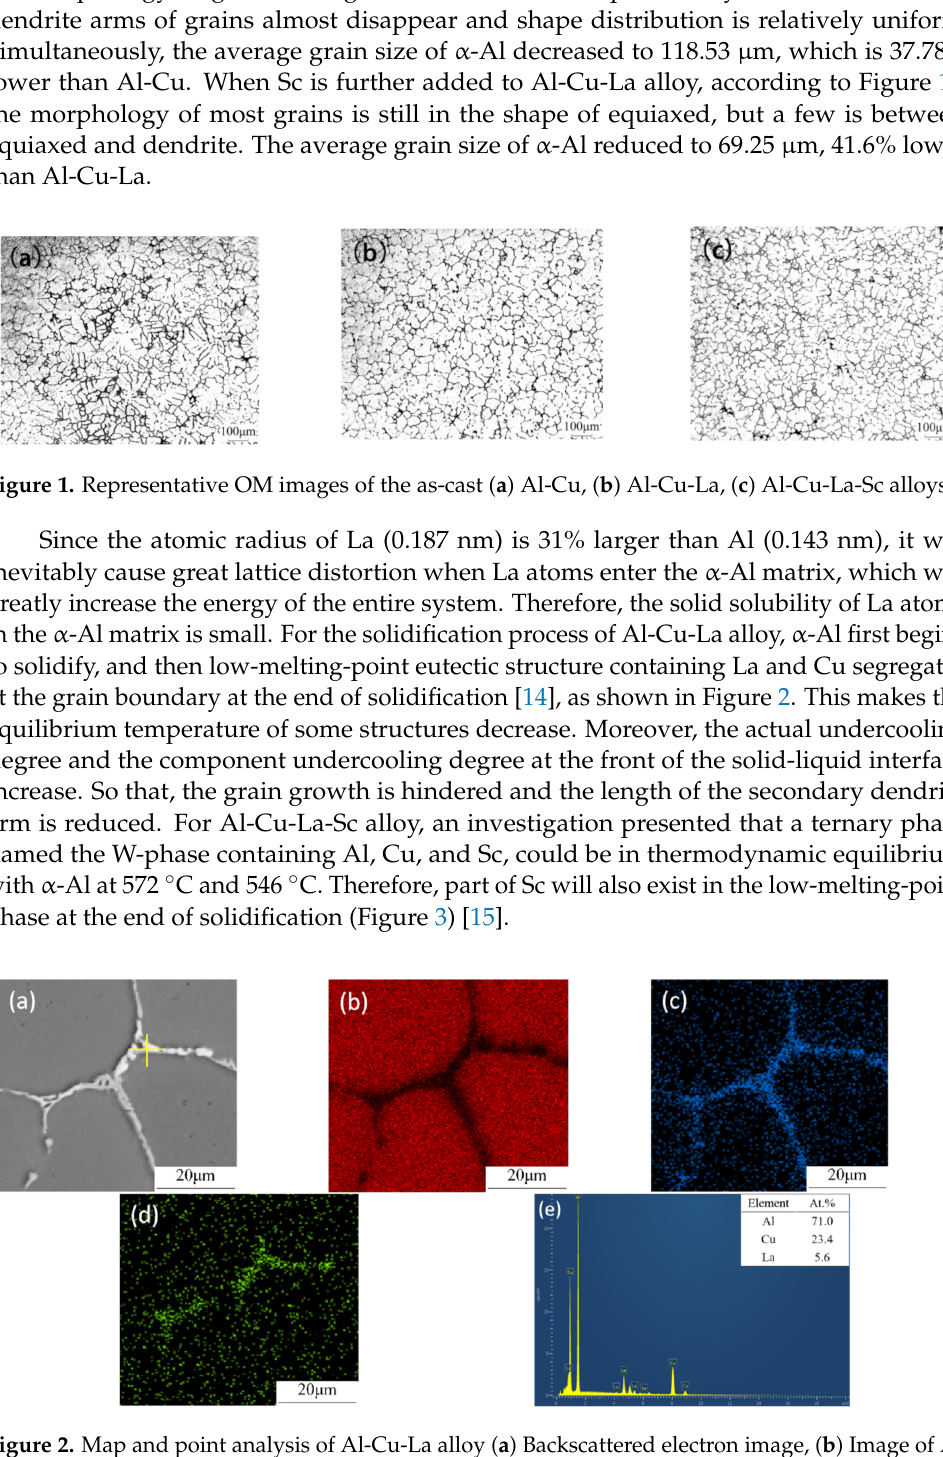
Figure 2. Map and point analysis of Al-Cu-La alloy ( a ) Backscattered electron image, ( b ) Image of Al, ( c ) Image of Cu, ( d ) Image of La, ( e ) Point